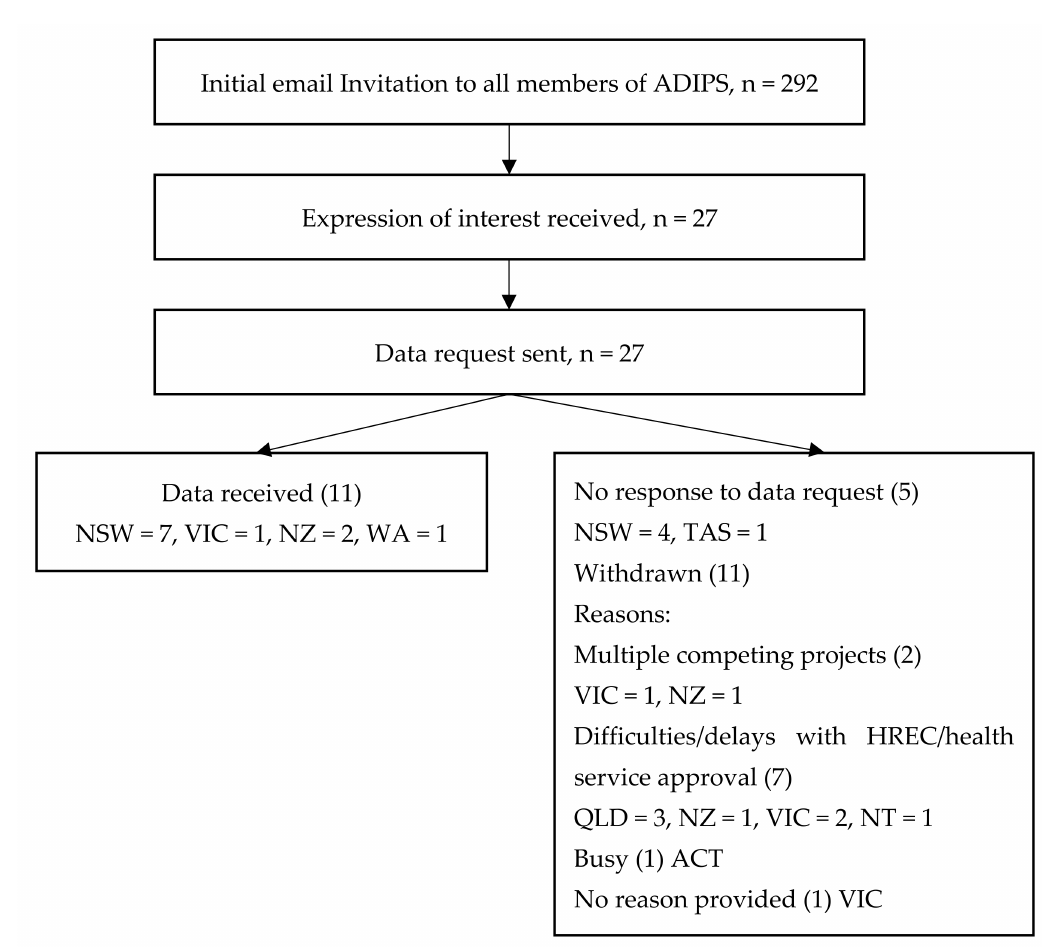
Figure 1. Flow chart of site selection process. ADIPS = Australasian Diabetes in Pregnancy Society; NSW = New South Wales, VIC = Victoria, NZ = New Zealand, WA = Western Australia; TAS = Tasmania, HREC = Human Research Ethics Committee; QLD = Queensland, NT = Northern Territory, ACT = Australian Capital